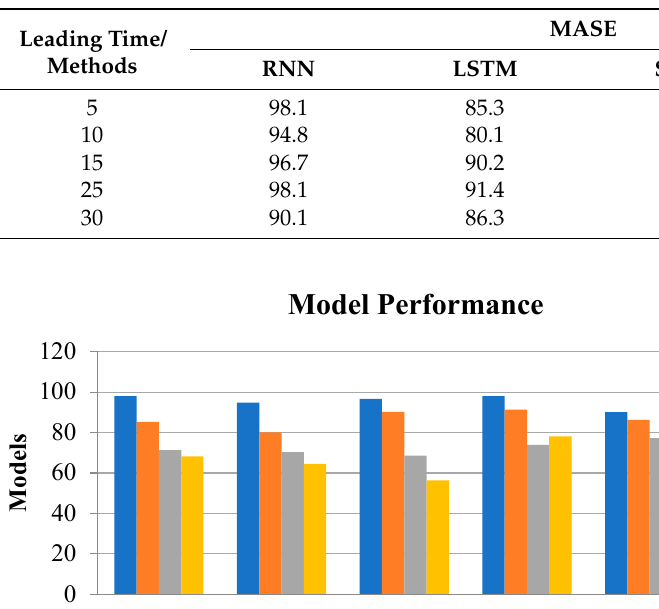
Table 2. Performance comparison with MASE.